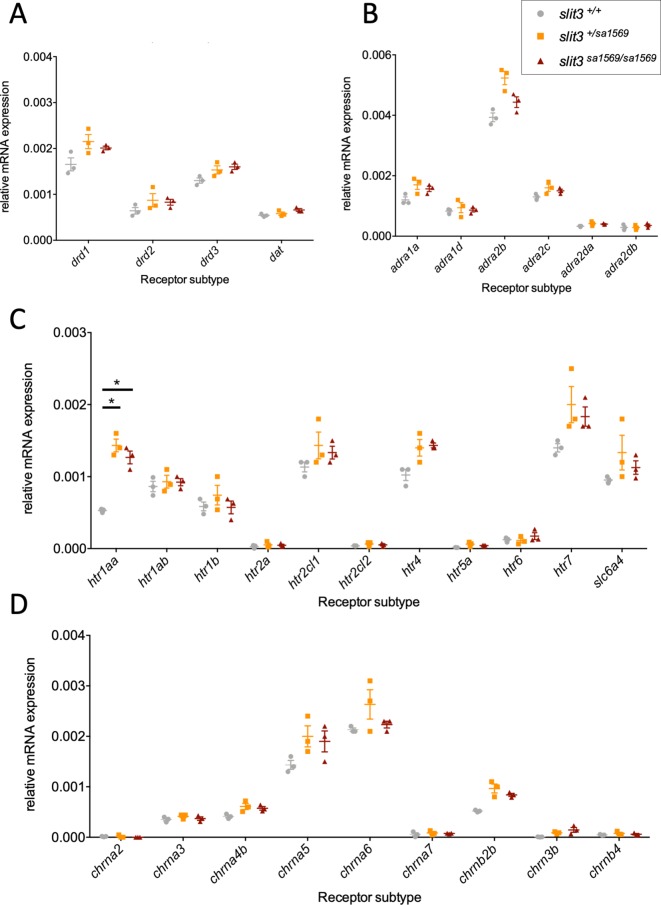
Quantitative real-time PCR analysis of five-day-old wild type slit3sa1569+/+, slit3sa1569/+ heterozygous and slit3sa1569/sa1569 homozygous mutant larvae.Quantitative PCR analysis of gene expression was performed for members of (A) dopaminergic signalling pathway, (B) adrenoreceptors, (C) serotonin signalling pathway and (D) nicotinic cholinergic receptors. (Total n=30, 3 samples per experimental group with n=10 embryos per sample). Only htr1aa ([F(2,6)=44], p=0.0003) showed a significant difference across genotypes after correcting for multiple testing. *Two-way ANOVA followed by post-hoc Tukey test (p < 0.05).Figure 8—source data 1.Gene expression data for slit3 mutant and wild type zebrafish.